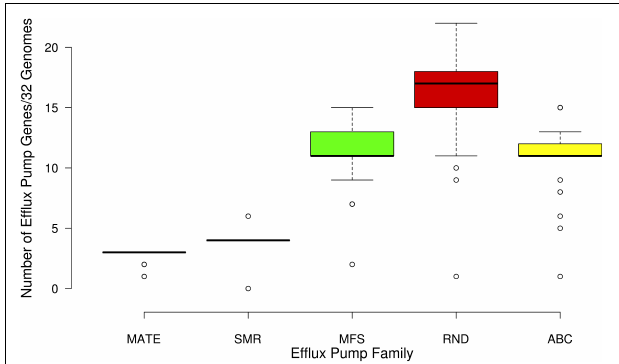
FIGURE 5 | Box plot showing the number of genes associated with the five families of efflux pumps identified in the 32 Serratia genomes: multidrug and toxic-compound extrusion family (MATE), the small multidrug resistance family (SMR), the major facilitate superfamily (MFS), the resistance nodulation division family (RND), and the ATP binding cassette superfamily